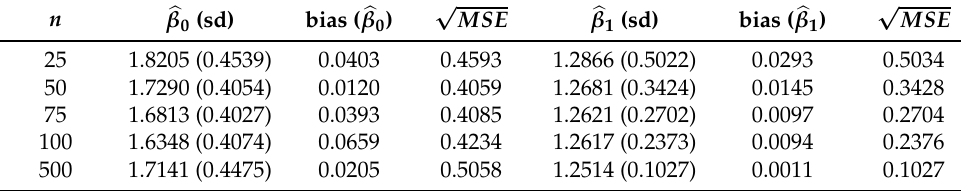
Table 6. Simulations for (cid:98) β 0 , (cid:98) β 1 .